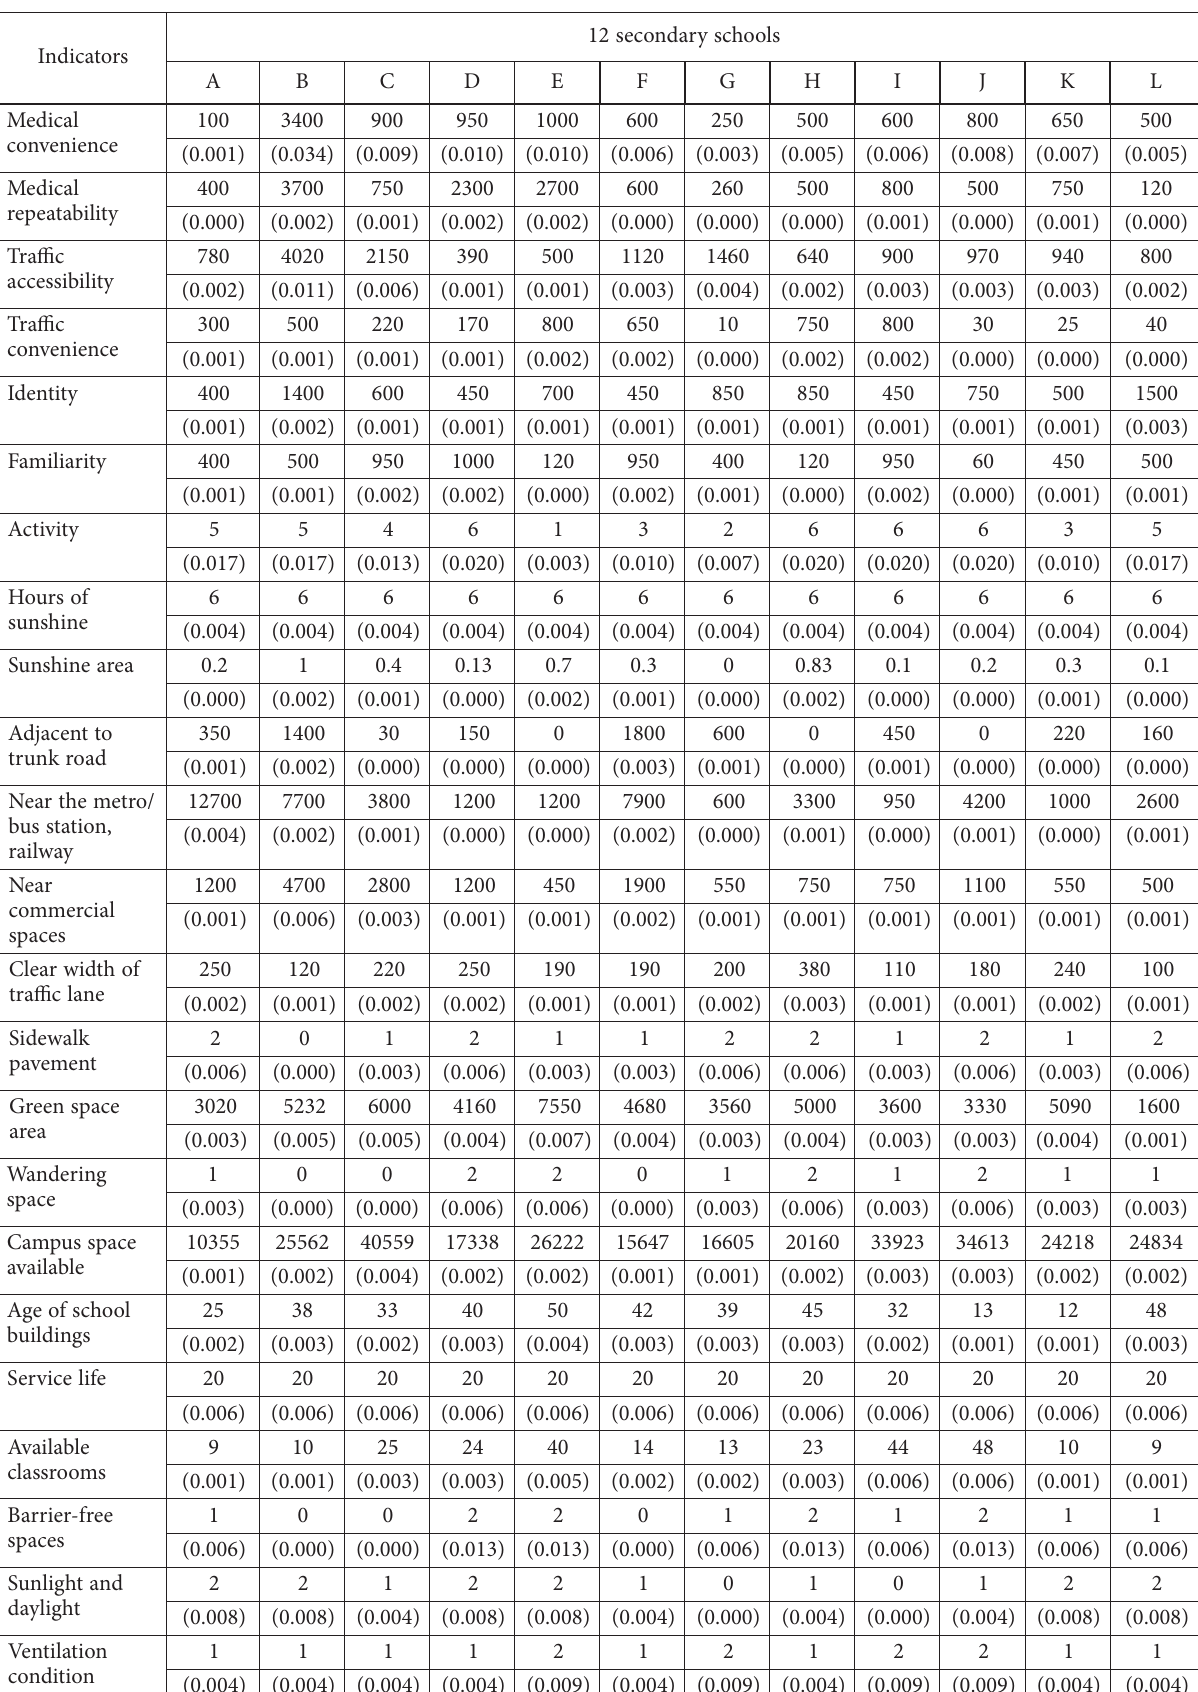
Table 7. Actual evaluation values and standardization and weighted matrix of various secondary school values